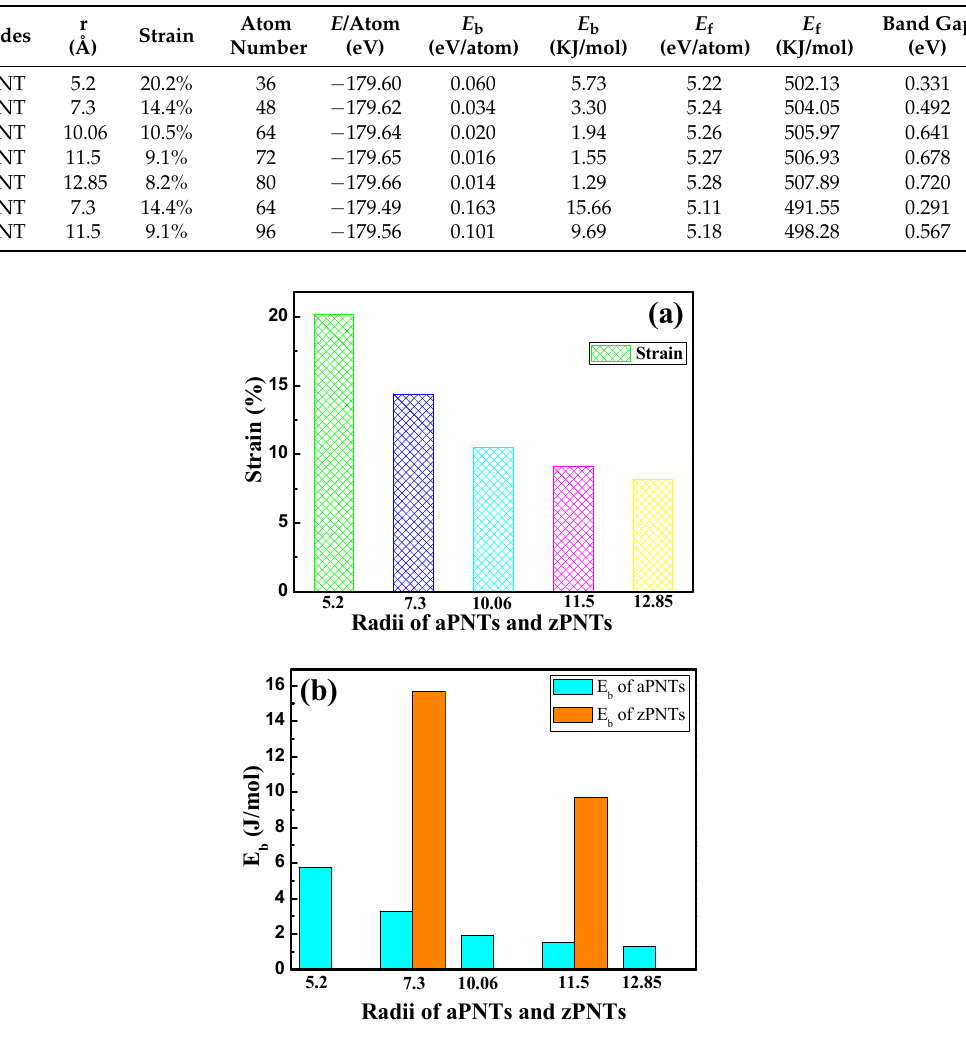
Figure 3. ( a ) Bending strain and ( b ) bending strain energy of aPNTs with different bending directions and radii. Table 2. Data of BP nanotubes with different bending directions and curvature radii. The energy per atom of planar monolayer BP ( E a ) is − 179.66 eV with a band gap of 0.763 eV. Modes